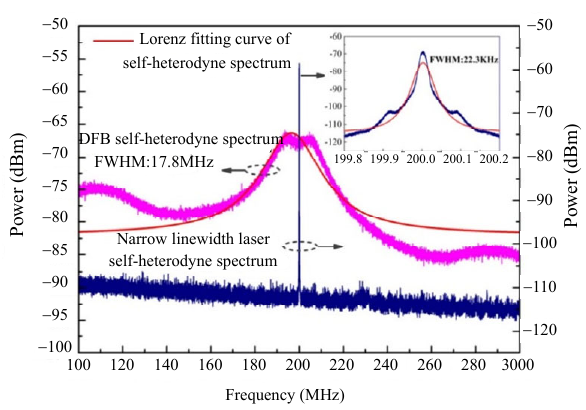
Fig. 7 Linewidth of narrow linewidth and medium-coherence laser.